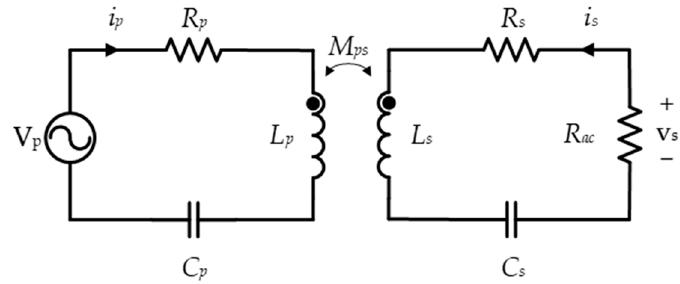
6 of 17 Figure 7. Voltage and current waveform according to switch on/o ff .